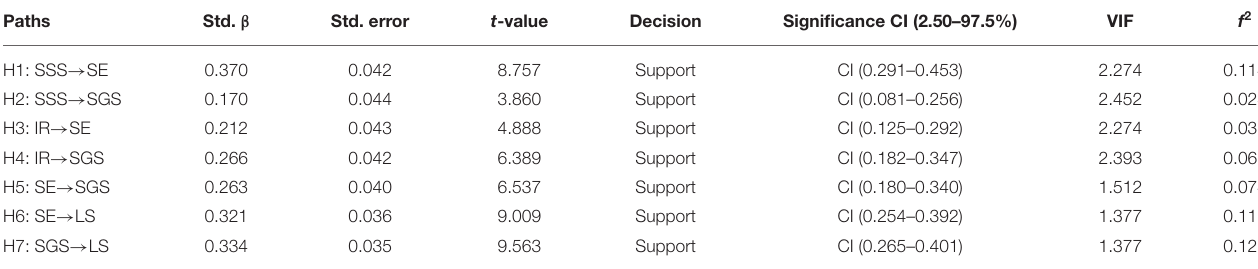
TABLE 4 | Results of the hypotheses testing. Paths